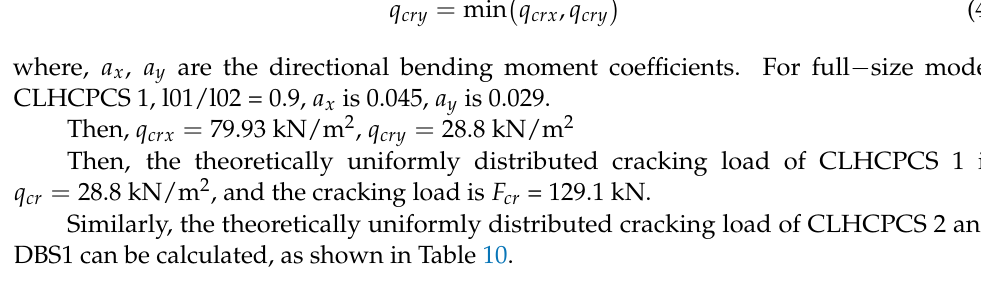
Table 10. Cracking load statistics of the superimposed surface of the